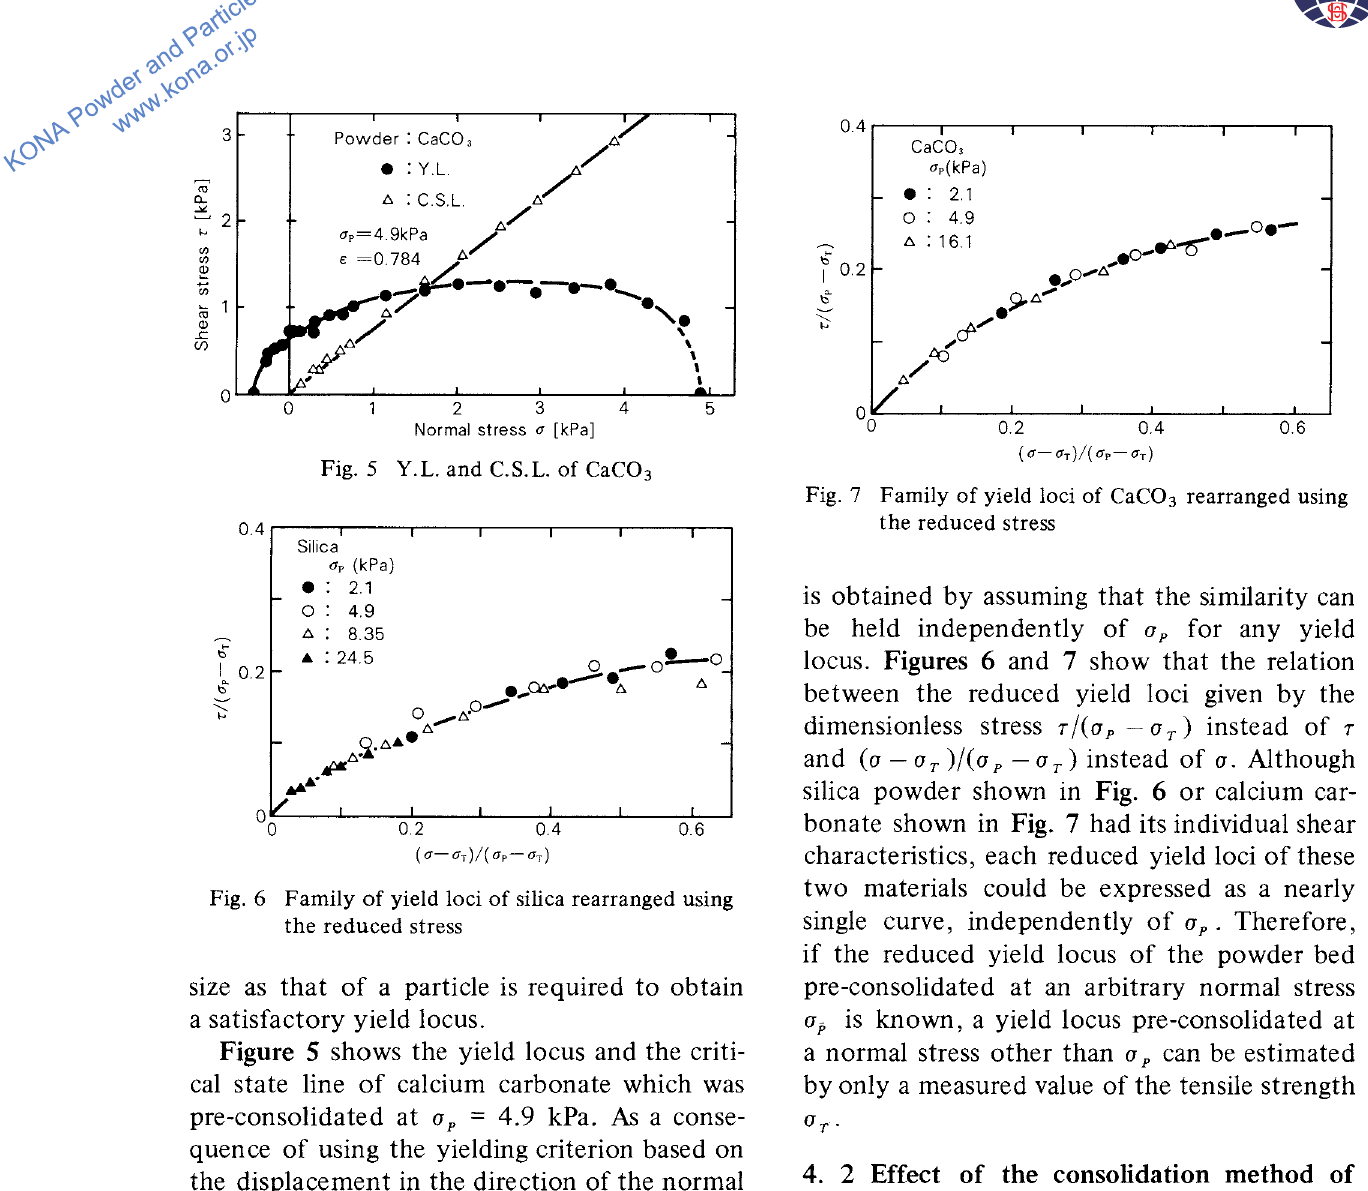
Fig. 5 Y.L. and C.S.L. of CaC0 3